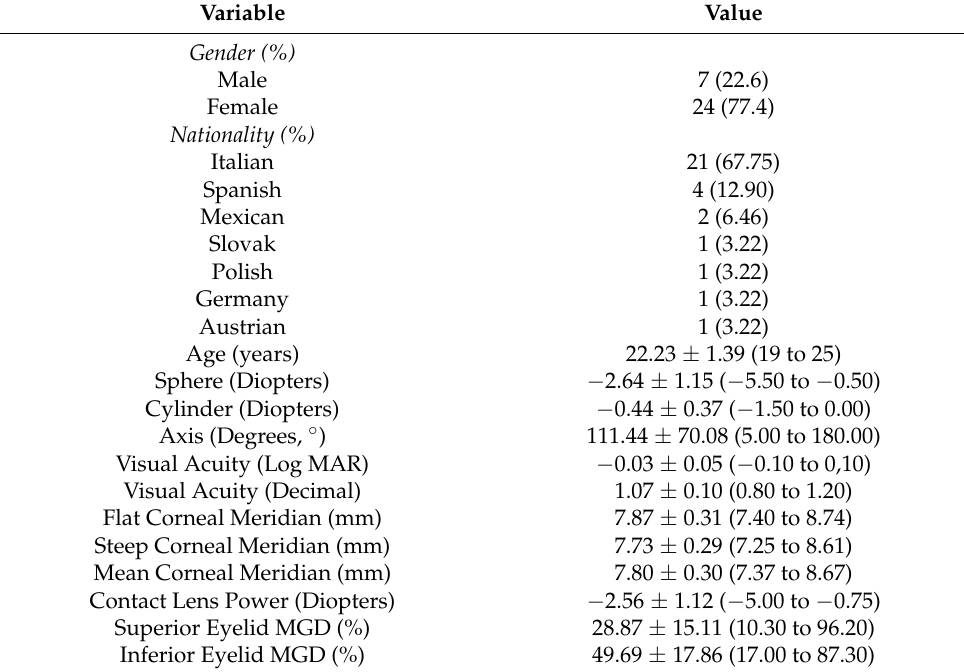
Table 1. Descriptive analysis of the